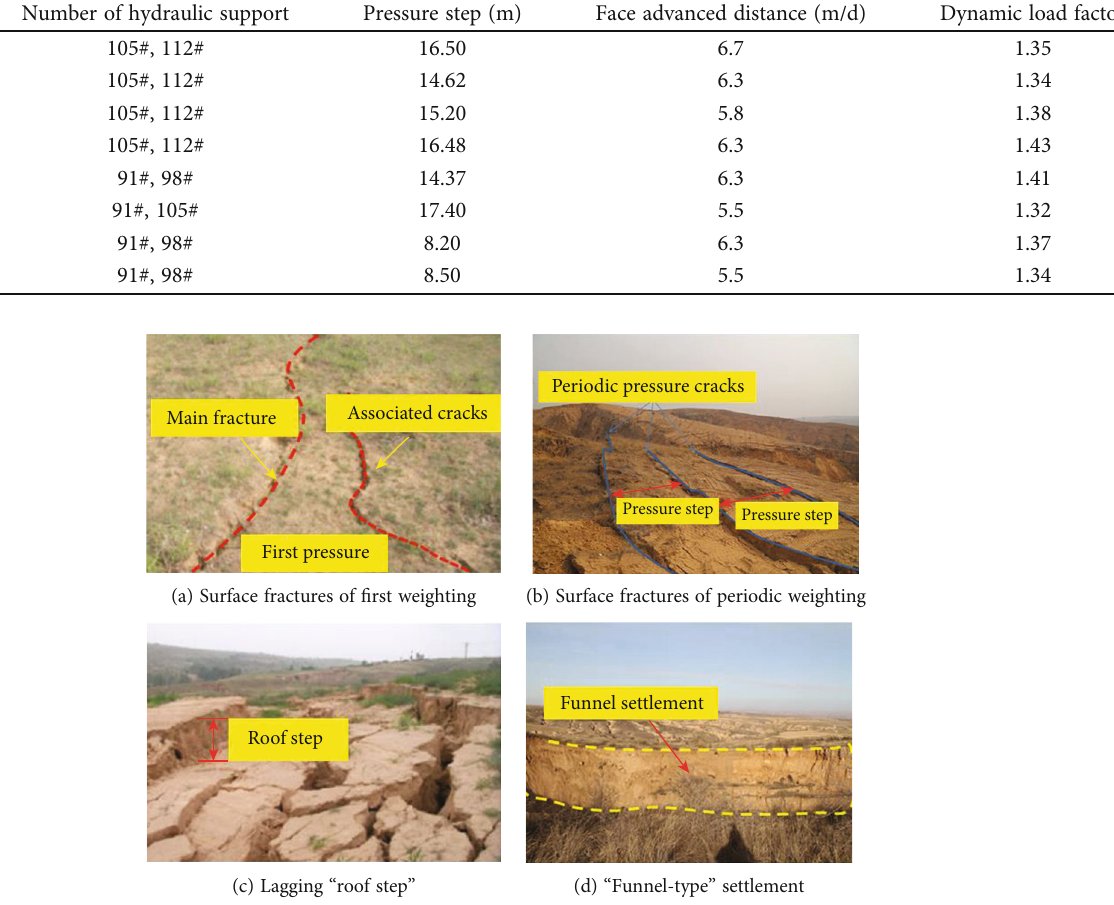
Figure 16: Destruction of surface subsidence map